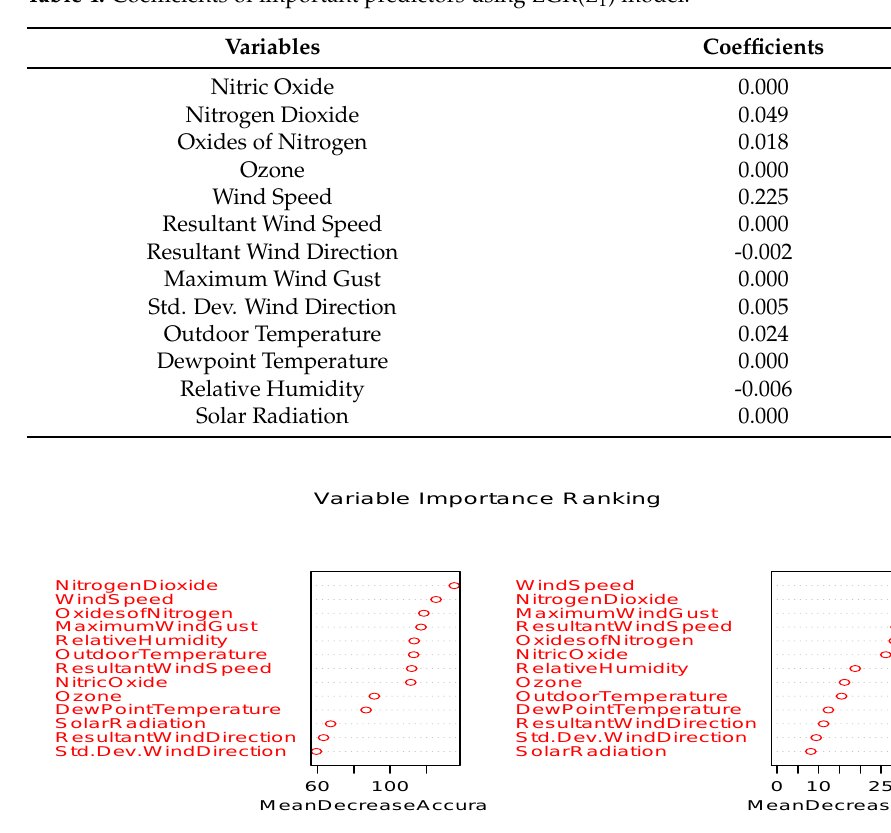
Table 4. Coefficients of important predictors using LGR( L 1 ) model.